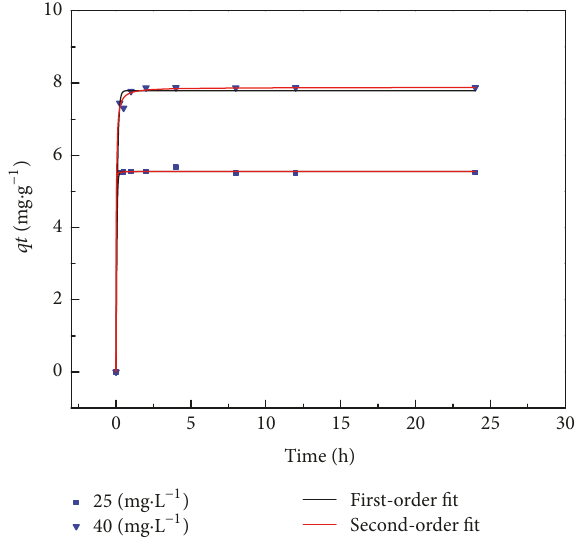
Figure 4: Adsorption kinetics of As(V) by CS-Fe (adsorbent dose 5gL −1 ; temperature 30 ∘